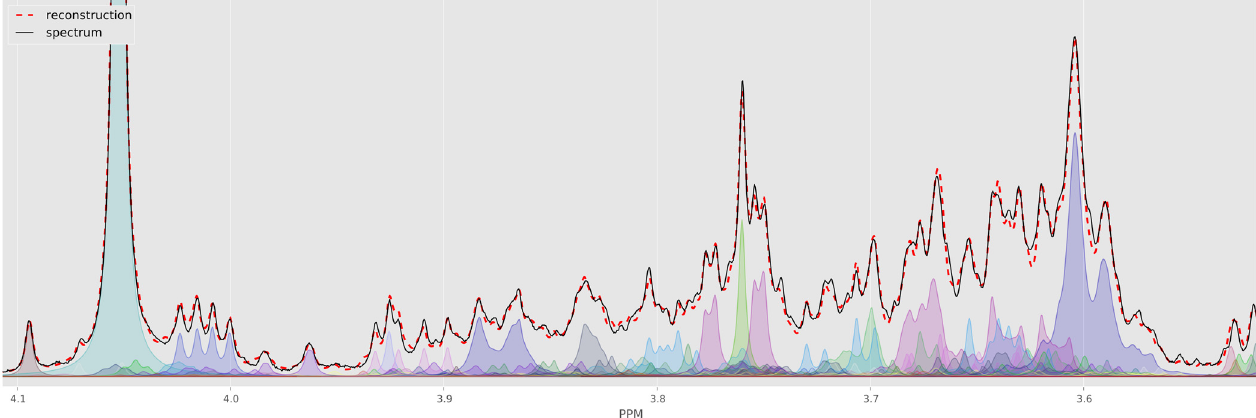
Fig 2. The crowded region (3.5 – 4.1 ppm) of a computer generated spectrum with 150 compounds (solid black) and the fit produced by Bayesil (dashed red) as well as individual clusters as quantified by Bayesil. Each cluster is free to shift a specified amount, which is at least 0.025 PPM.